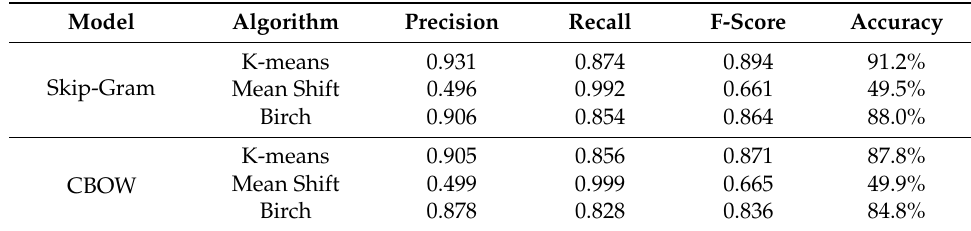
Table 13. Summary for clustering algorithms with entity embedding models on training dataset.